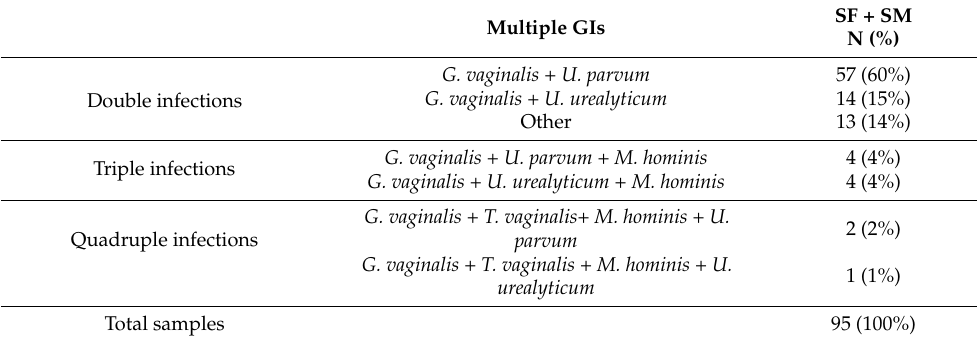
Table 2. Analysis of multiple GIs detected in female and male